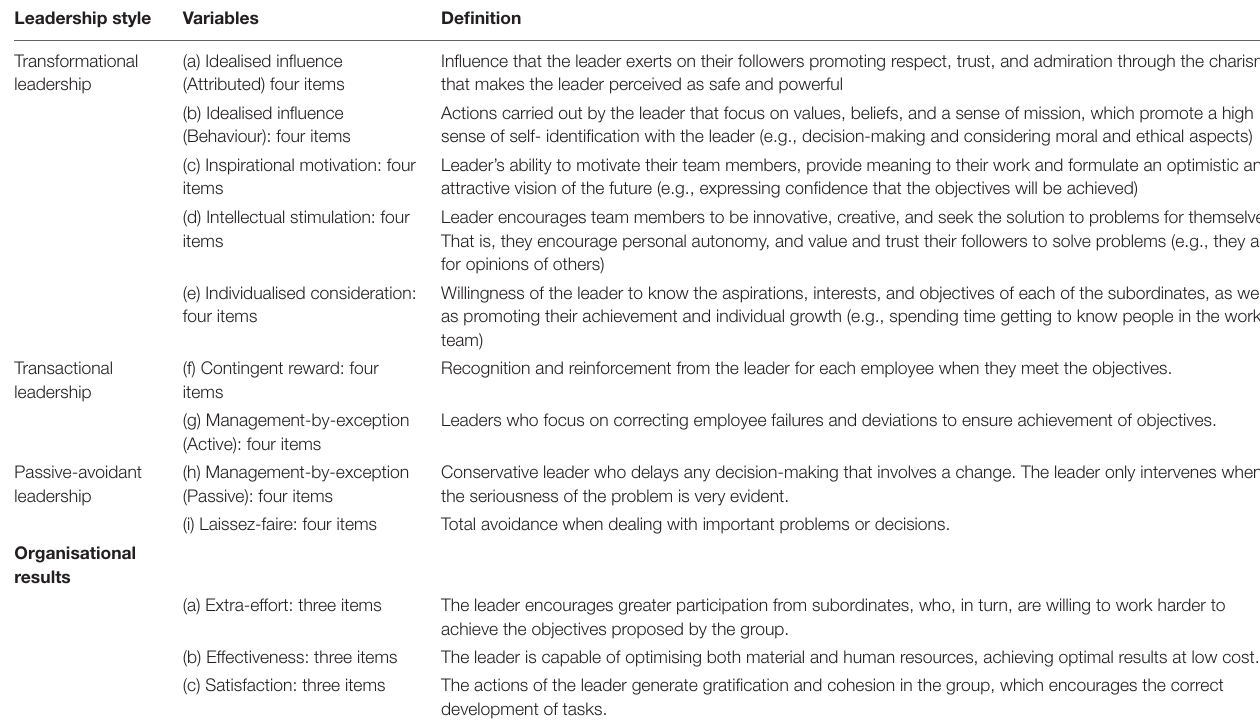
TABLE 1 | Factor structure of